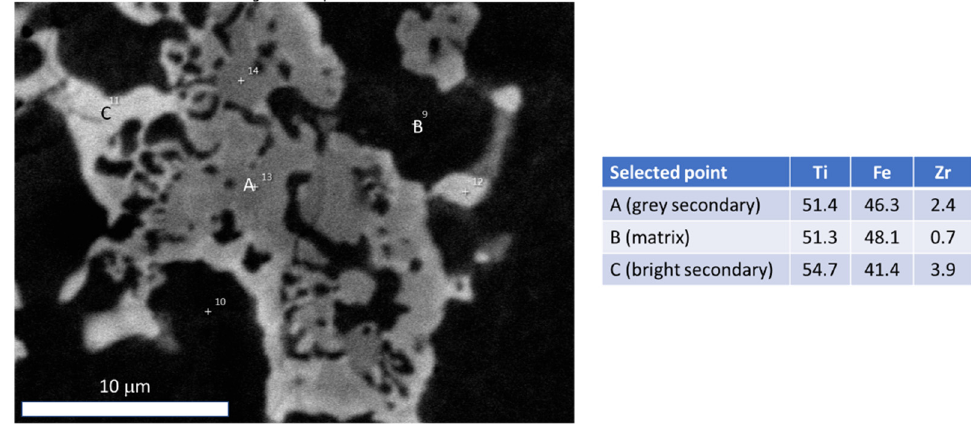
Figure 3. Element distribution in as-cast TiFe + 4 wt.% Zr. (adapted with permission from ref. [19], 2016, Elsevier).